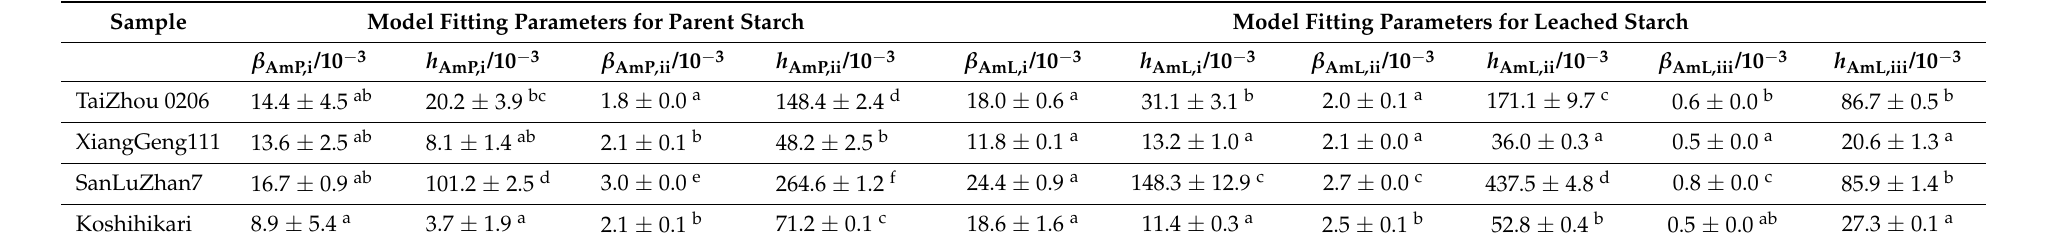
Table 1. Parameter values from fitting the biosynthesis-based model to the amylose CLDs for parent starch and leached starch.